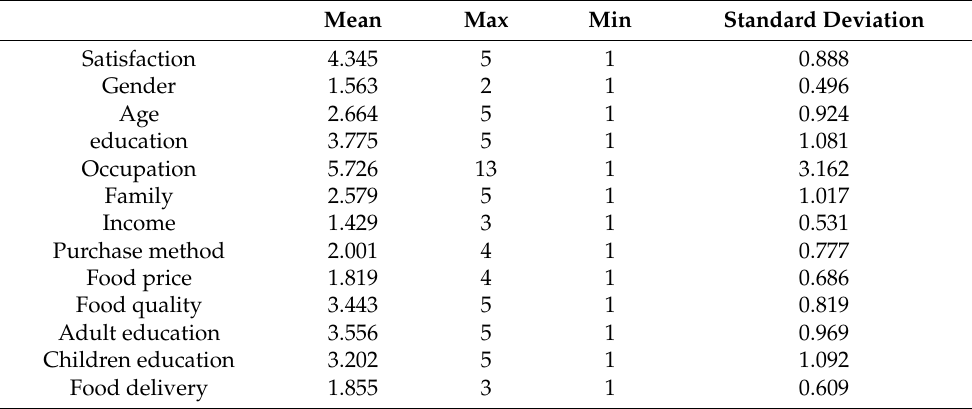
Table 2. Summary